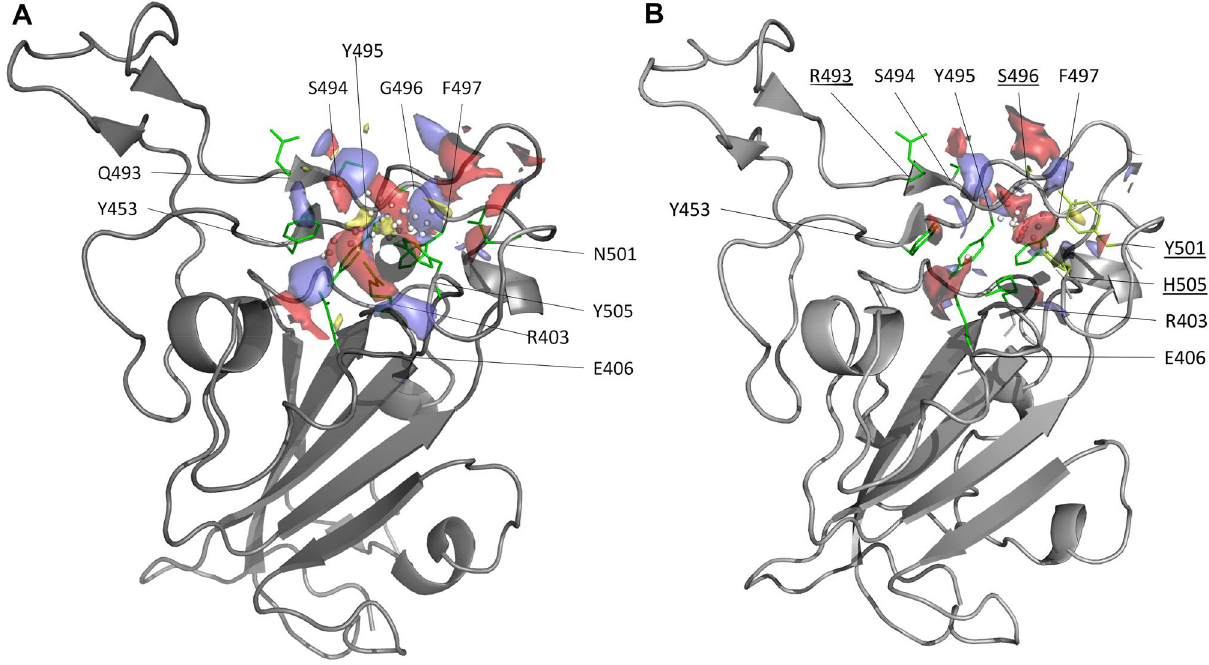
Figure 1. Predicted SiteMap pockets on the Spike surface at the RBD/ACE2 interface. Delta ( A ) and Omicron ( B ) variants are represented as solid grey ribbons and residues lining the pockets are colored in green. Pockets are shown with their relative surfaces, indicating the regions for hydrophobic (yellow), hydrogen bond donor (blue) and acceptor (red) functional groups. Mutated residues in the Omicron variant are underlined. (Table 1). Edge of the larger Delta pocket also included Tyr453, Gln493 and Ser494. The predicted site overlapped with that of Spike RBD identified using FTMap and DeepSite and used as target for docking 23 . Analysis of the non-bonded interactions showed that in both Spike proteins residues at 496, 501 and 505 positions interact with Lys353 and Tyr41 of ACE2. In addition, Delta Gln493 and Omicron Tyr453 of Spike contact ACE2 Glu35 and His34, respectively. Given the challenges of identifying druggable sites on PPIs, pockets detected by SiteMap which rely on static protein conformations were assessed by molecular dynamics simulations (MD). The binding site volume was calculated along the MD trajectory and plotted over the simulation time using the script trajectory_binding_site_ volumes.py available in the Schrödinger suite of software. As evident in the Fig. 2, no significant differences existed in the binding-pocket volumes of the two simulated systems. The pockets were stable over the simulation time and an average binding-pocket volume of 53.0 Å 3 and 56.5 Å 3 was calculated for Delta and Omicron variants, respectively. A major fluctuation was observed in Omicron suggesting that its pocket structure may acquire a more expanded conformation as compared to Delta.